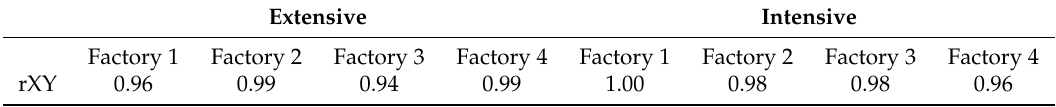
Table 10. The Pearson correlation coefficient (rXY) for thermal resistance and water content in weight. Extensive